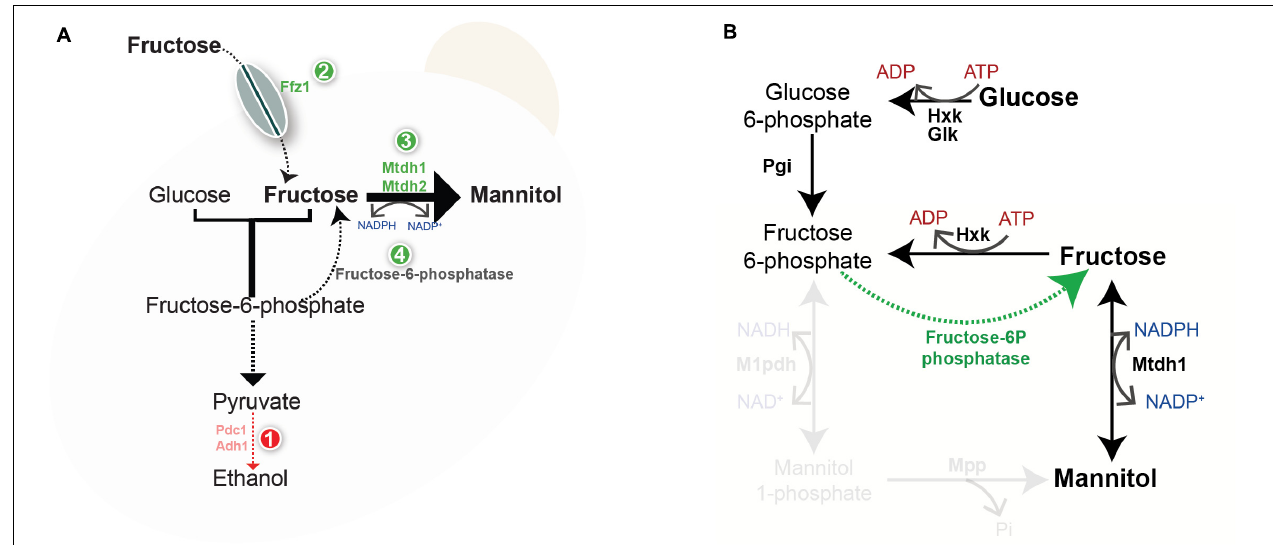
FIGURE 5 | Working model for the evolution of mannitol metabolism. (A) Lack of or inefficient alcoholic fermentation (1) causes redox constraints that can be partly alleviated by oxidized cofactor recycling by the mannitol dehydrogenase reaction. Acquisition of Ffz1 (2) and duplication of the MtDH gene (3) may have supported an increase in the flux toward mannitol production. In order to harvest the advantages of mannitol production also when glucose is the sole carbon and energy source a novel pathway (4) emerged converting fructose-6-P to fructose. (B) Novel pathway mediating the production of mannitol from glucose in W/S-clade yeasts; Hxk- Hexokinase, Glk- Glucokinase; Pgi- Phosphoglucose isomerase, Mtdh1- Mannitol dehydrogenase. Reactions involving M1pdh and Mpp are faded to indicate that they are absent in W/S-clade